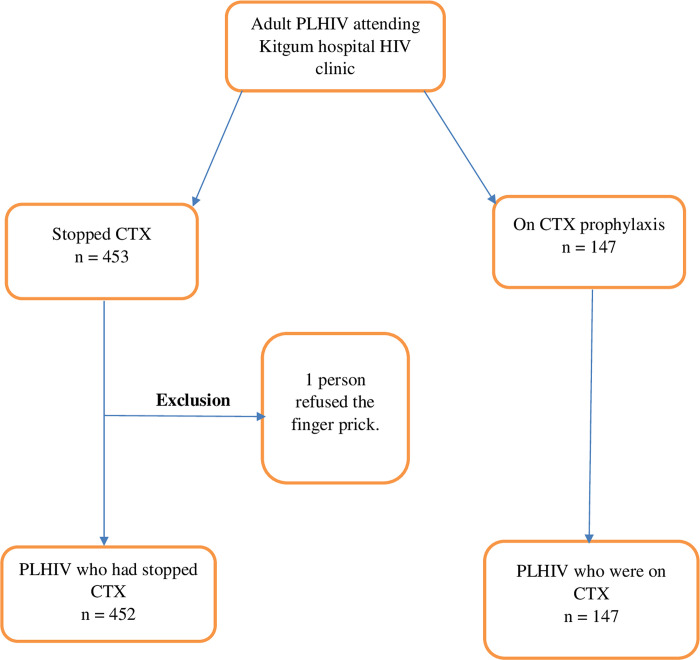
Participant recruitment to the study.